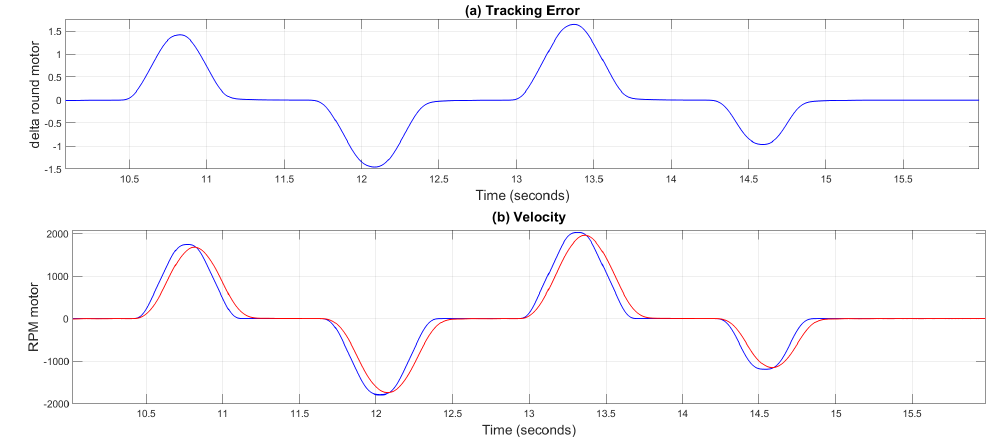
Figure 22. ( a ) Tracking Error, ( b ) Velocity: reference profile (blue line), measured velocity (red line) in a shorter time